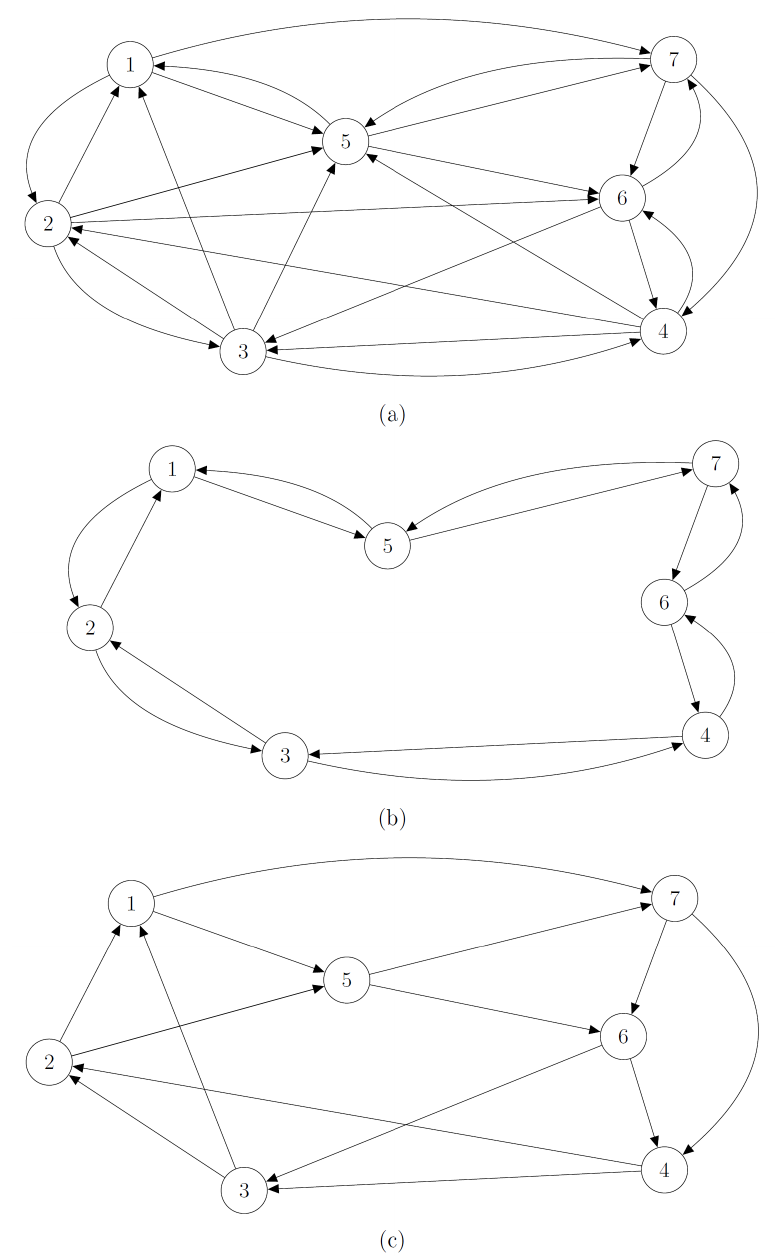
Figure 1: (a) A 2 -vertex strongly biconnected graph. (b) An optimal solution for the minimum 2 -vertex-connected spanning subgraph problem. But note that this subgraph is not 2 -vertex strongly biconnected because the underlying graph of the subgraph obtained by removing vertex 1 is not biconnected. (c) An optimal solution for the minimum 2 -vertex strongly biconnected spanning subgraph